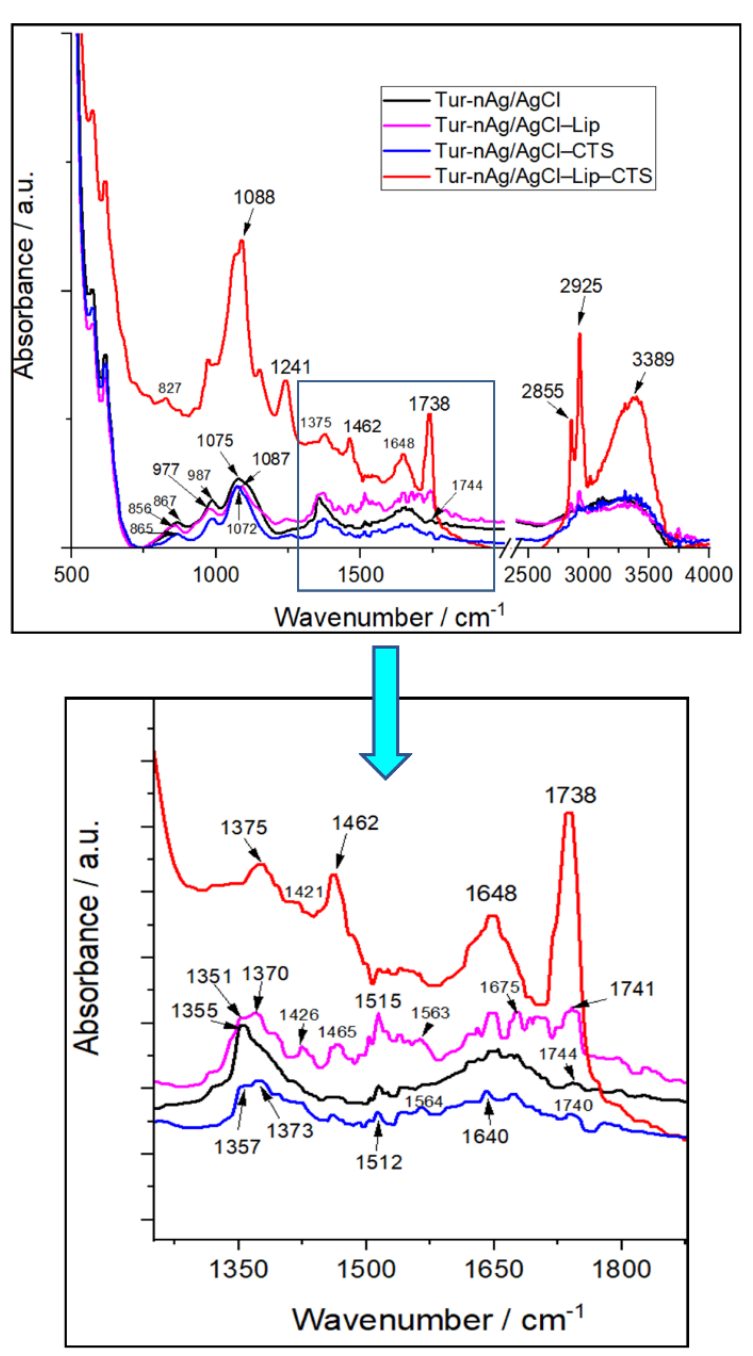
Figure 1. UV-Vis absorption spectra of silver-containing materials.